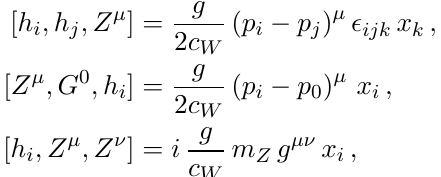
(cid:22)(cid:11)(cid:12) with three Higgs h i ; h j ; h k in the